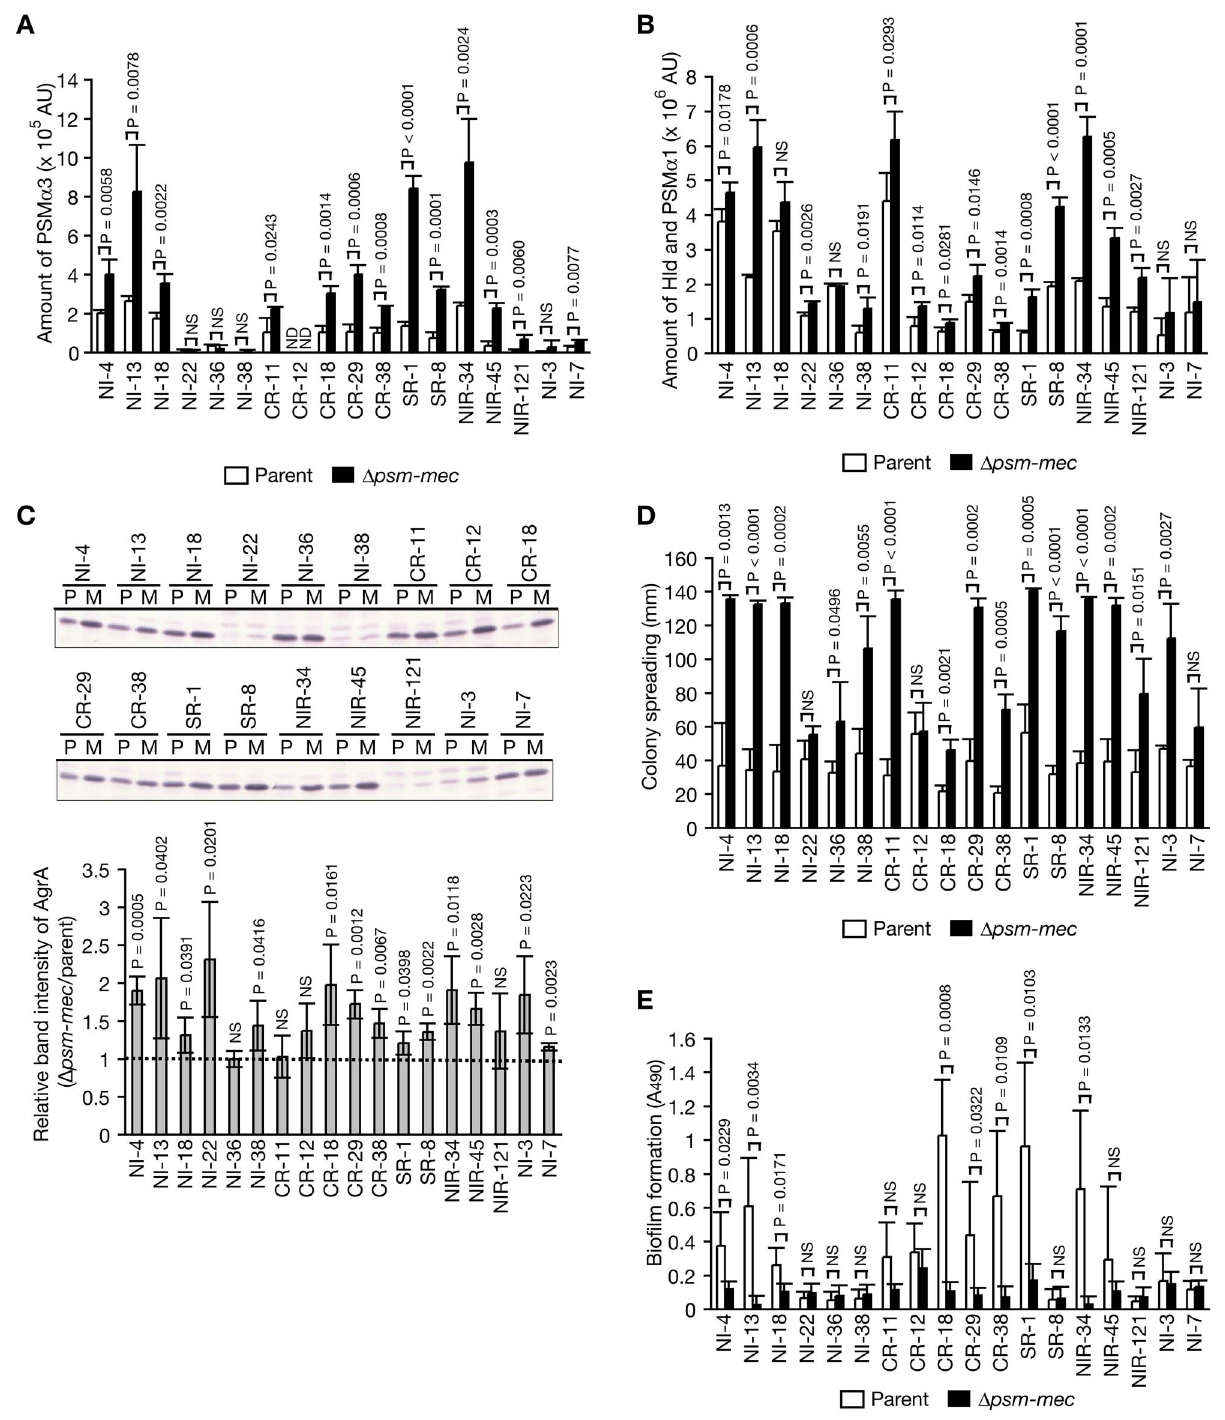
Figure 6. Deletion of psm-mec in MRSA clinical isolates increases the PSM a production, agrA expression, and colony spreading, whereas decreases biofilm formation. ( A, B ) The amounts of PSM a 3 (A) and Hld + PSM a 1 (B) of 18 MRSA isolates and its psm-mec- deleted mutants were measured. White bar represents the clinical isolate used as the parent strain. Black bar represents the psm-mec -deleted mutant of the clinical isolate. The vertical axis represents the amount of PSM a s in arbitrary units based on A 215 . Means 6 standard deviations from three independent experiments are shown. Student t-test P-values between the parent strain and the psm-mec -deleted mutant are presented. NS, P . 0.05. ( C ) Cell extracts (3.7 m g protein) of 15 h-cultures of clinical MRSA isolates and the psm-mec -deleted mutants were subjected to Western blotting by anti-AgrA IgG (Upper panel). Band intensities of AgrA were measured and are presented as relative values against that of the parent strain (Lower graph). Means 6 standard deviations from three independent experiments are presented. Student t-test P-values between the parent strain and the psm-mec -deleted mutant are presented. NS, P . 0.05. ( D ) Colony spreading abilities of clinical MRSA isolates and the psm-mec -deleted mutants were evaluated. Overnight cultures were spotted onto soft agar plates and incubated for 24 h at 37 u C. The vertical axis represents diameters of giant colonies. Means 6 standard deviations from three independent experiments are shown. Student t-test P-values between parent strain and the